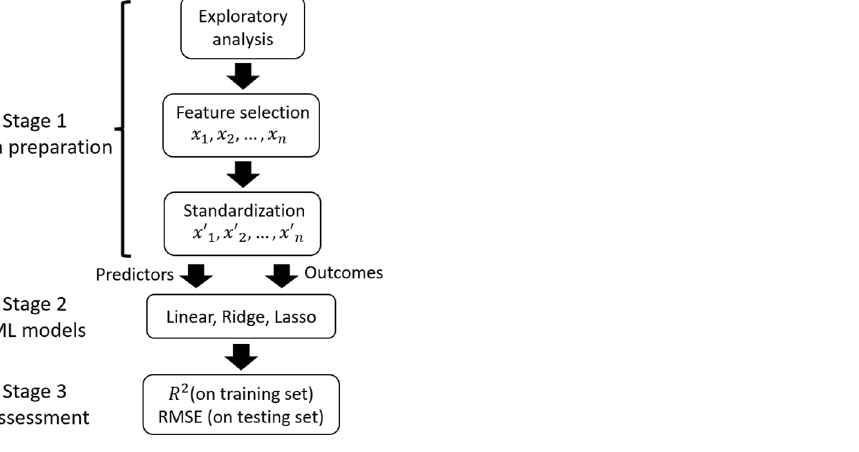
Figure 1. Scheme of the processing pipeline: from data inspection to model assessment. Structural and elastic properties were employed as predictors, while plastic properties were considered as